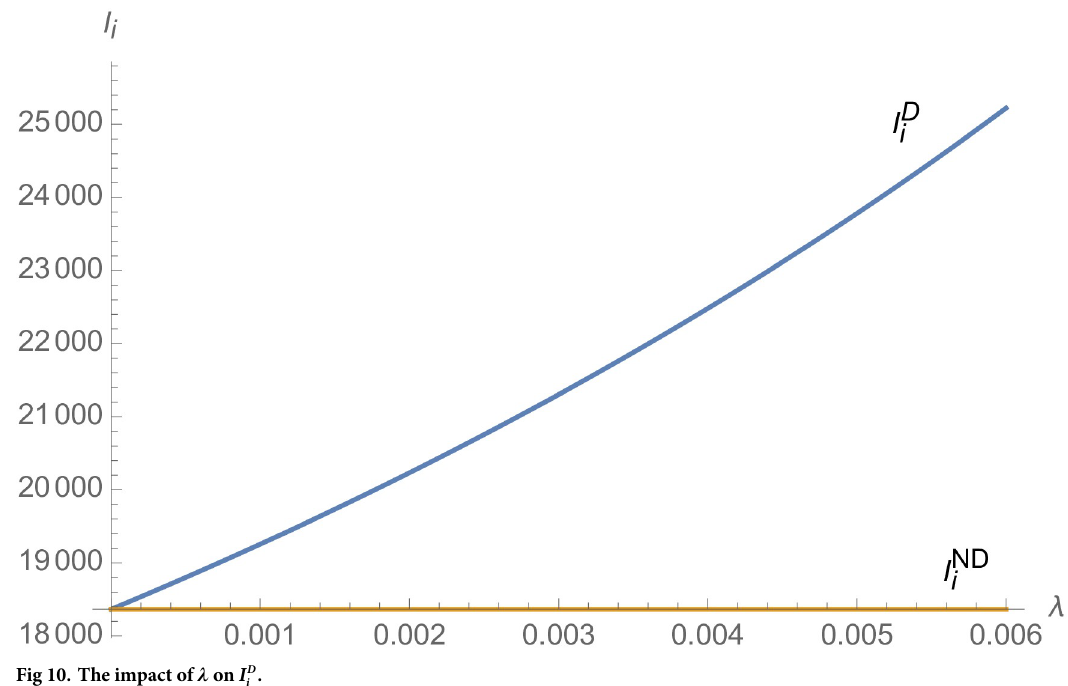
Fig 10. The impact of λ on I D